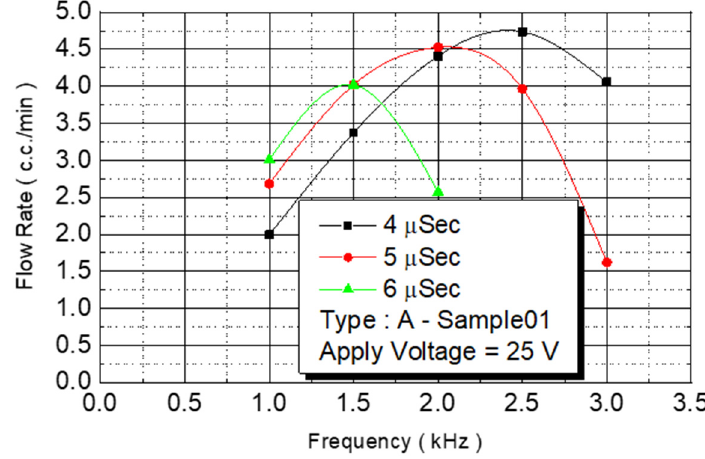
Figure 10. A Type - Sample01 flow test. Figure 10. A Type-Sample01 flow test.